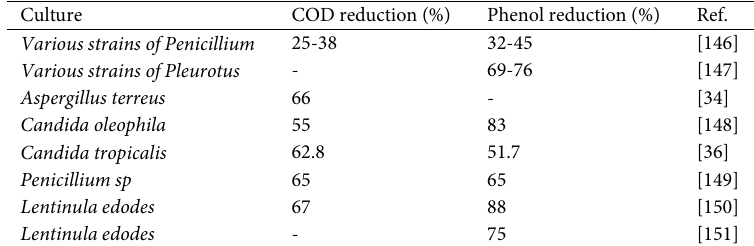
Table3. Aerobic treatment of OMW Table 2. Aerobic treatment of